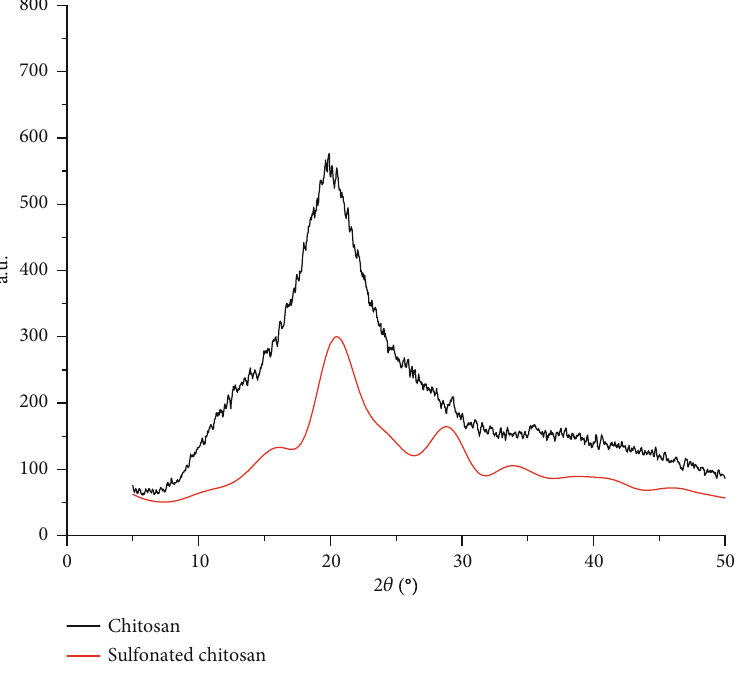
Figure 2: XRD patterns of chitosan and sulfonated